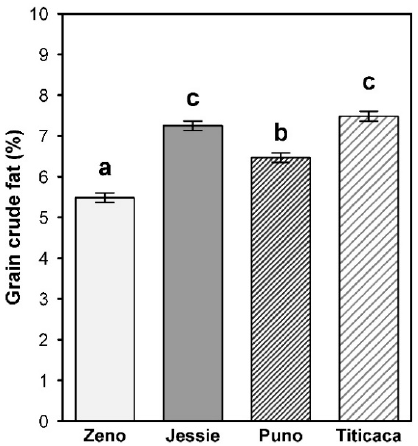
Table 8. Two-year mean values of fatty acid composition (in g 100 g − 1 crude fat, ± SE 1 ) for the four quinoa cultivars (Zeno, Jessie, Puno, Titicaca). Means in one row followed by the same letter are not significantly different from each other ( p < 0.05).